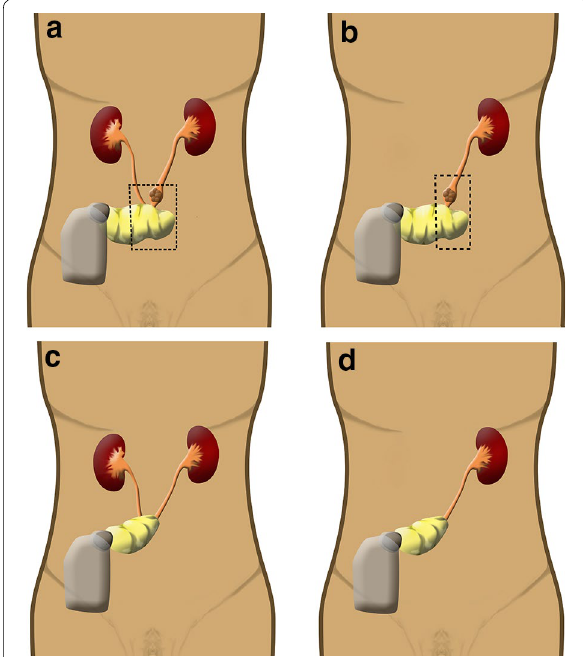
Fig. 2 Schematic drawing of the segmental ureteroileal conduit resection technique. a and b , The tumor to be segmentally removed ( indicates by the dashed line ). c and d , Patients after segmental ureter‑ oileal conduit resection operation